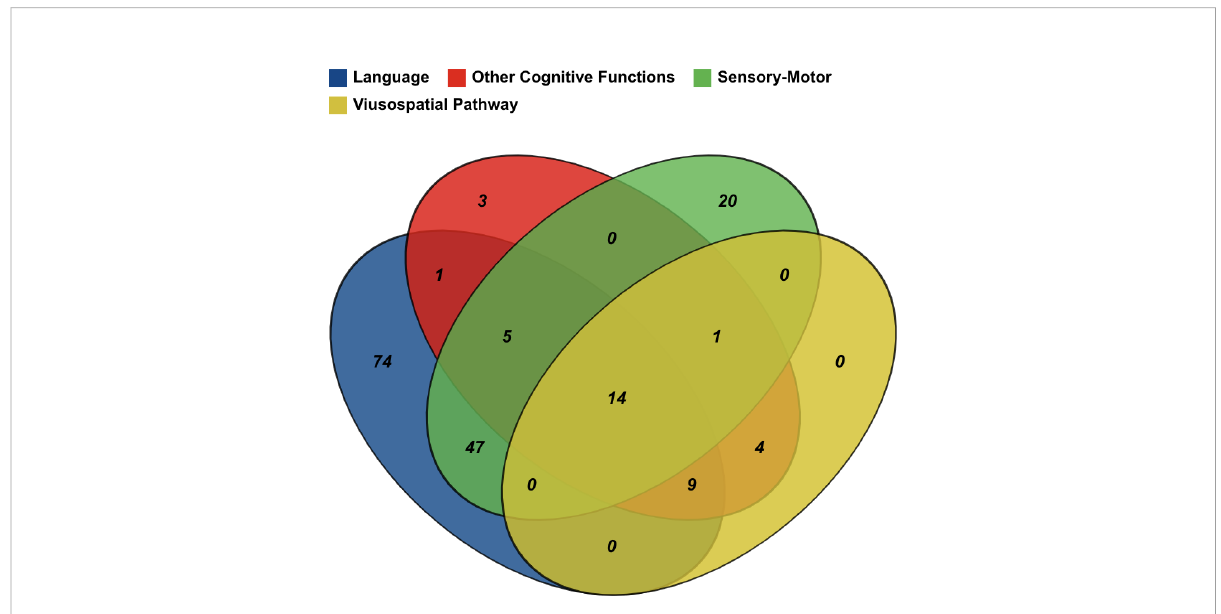
FIGURE 4 The Well diagram shows the tested functions in the included surgical case